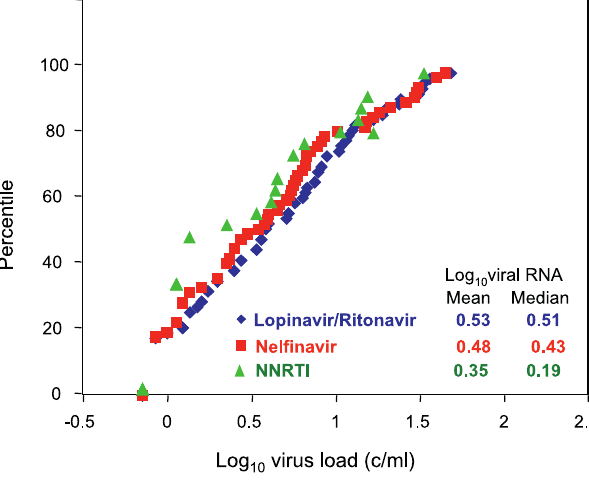
Figure 2. Distribution of Plasma HIV-1 RNA Levels in Patients with Persistently Suppressed Viremia (HIV-1 RNA , 50 Copies/ml from Week 24 to 60) on Standard Antiretroviral Therapy Week 60 viral RNA levels for M98–863 patients on LPV/r- (blue) or NFV- containing (red) regimens were determined by SCA. The percentile of patients in each group with a given RNA level is presented. SCA determinations for patients on NNRTI- containing regimens ( n ¼ 28) for . 1 y are included (green). The inset shows the mean and median log 10 RNA levels for each